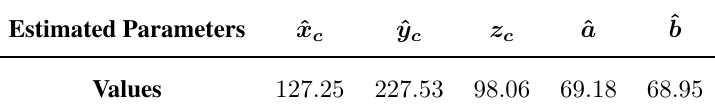
Table 1. The estimated parameters of the elliptical cylinder (m).